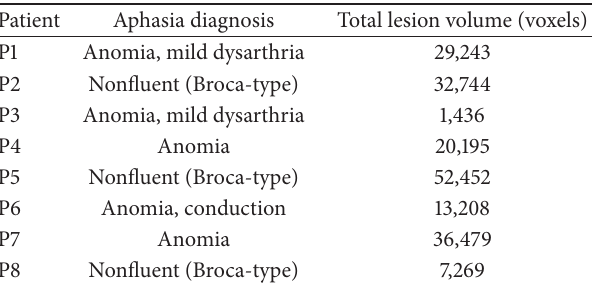
Table 1: Patient